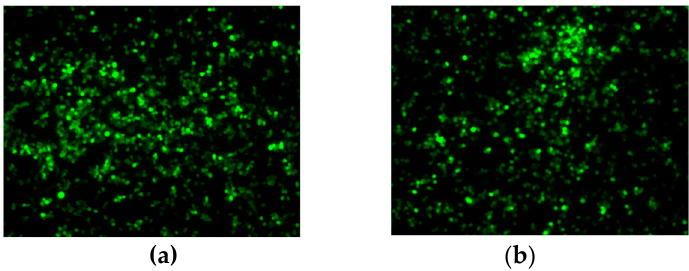
Figure 3. Enhanced-green fluorescence protein (EGFP) expression in CH-SAH infected with recombinant FAdV-4 viruses. CH-SAH cells were infected with ( a ) rFAdV-4ON1 ∆ 16-17EGFPCA-R and ( b ) rFAdV-4ON1 ∆ 16-17EGFPCA-L and examined by fluorescence microscopy. Images were taken three days post-infection. Magnification 50×.